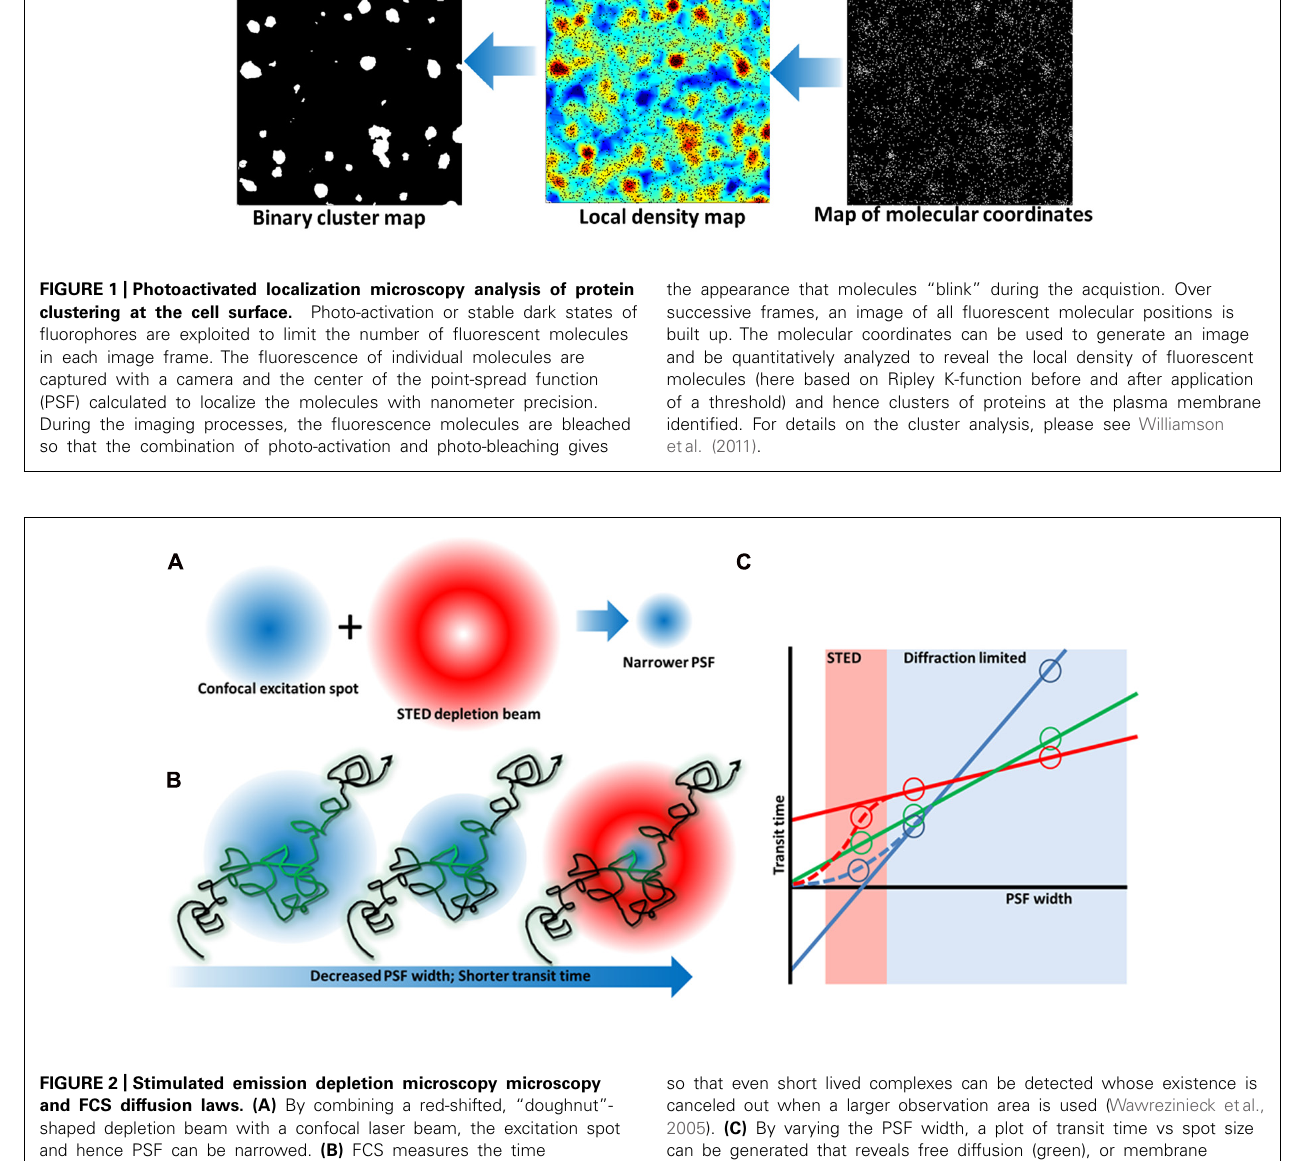
FIGURE 2 | Stimulated emission depletion microscopy microscopy and FCS diffusion laws. (A) By combining a red-shifted, “doughnut”- shaped depletion beam with a confocal laser beam, the excitation spot and hence PSF can be narrowed. (B) FCS measures the time fluorescent molecules take to diffuse through the focus of a stationary beam. By decreasing the PSF width, the transit time becomes shorter